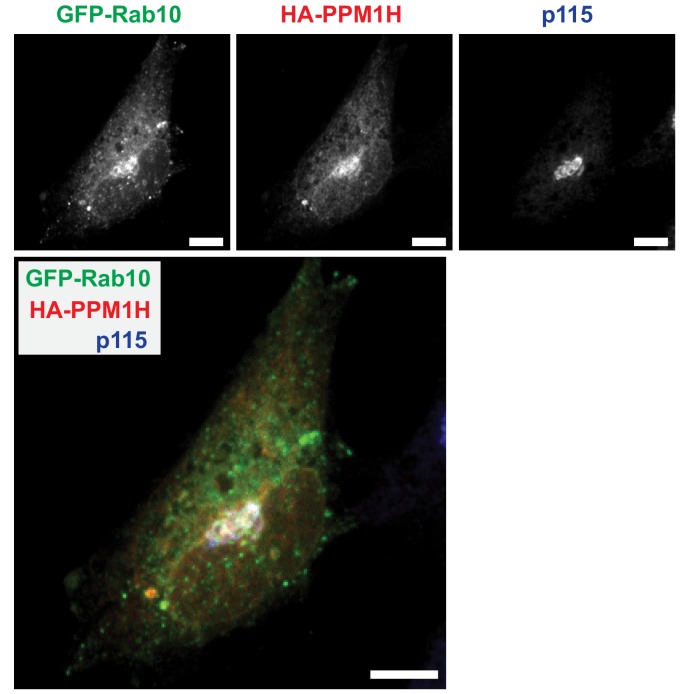
Localization of PPM1H and GFP-Rab10 in RPE cells.RPE cells were transiently transfected with HA-PPM1H and GFP-Rab10 plasmids. Cells were subsequently stained with rabbit anti-HA antibody (red), mouse anti-p115 (blue), and native GFP fluorescence is shown in green. Scale bars, 10 µm. Shown are maximum intensity projections.